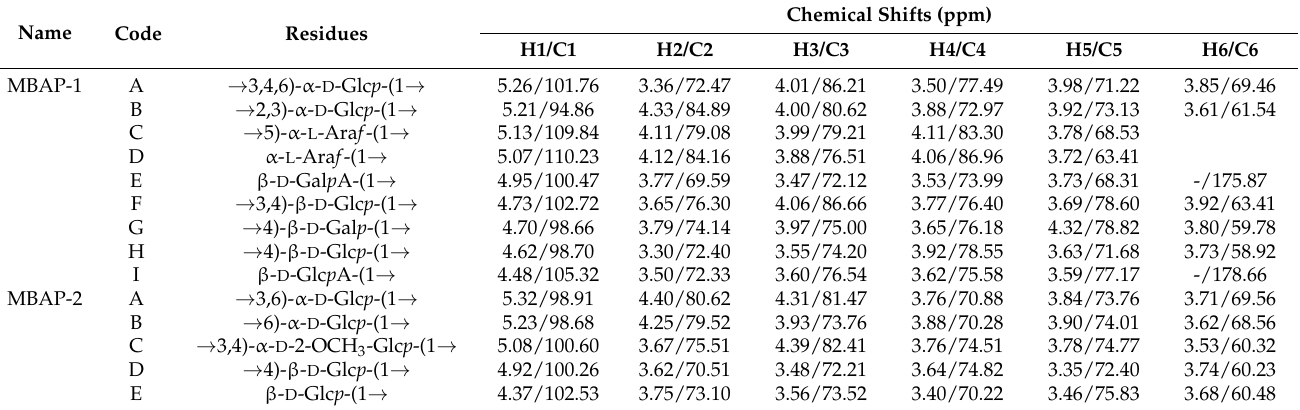
Table 4. 1 H-NMR (600 MHz) and 13 C-NMR (150 MHz) chemical shifts of MBAP-1 and